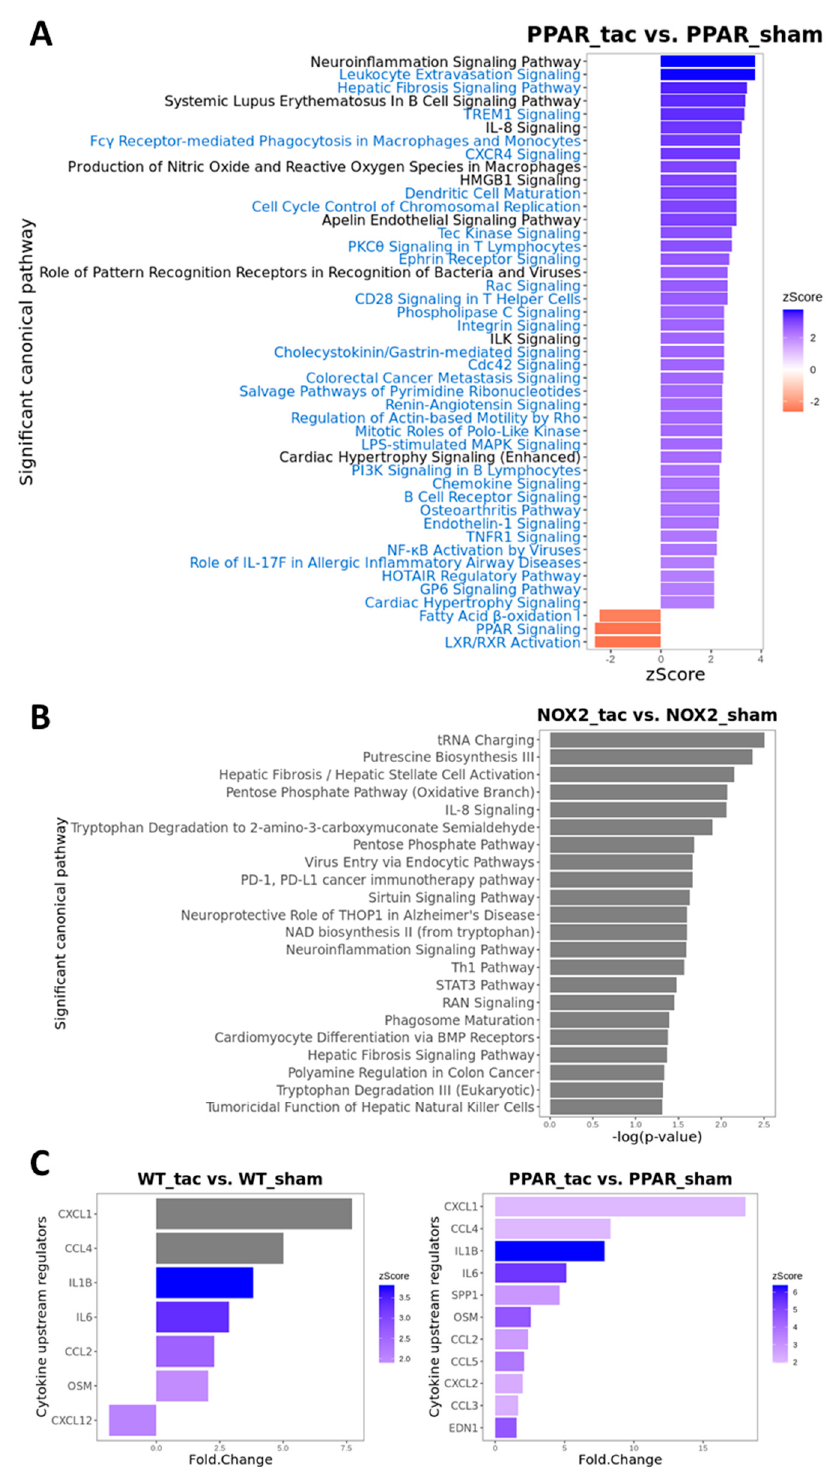
Figure 8. Canonical pathway analysis of differentially expressed genes using IPA. ( A ) Significantly enriched pathways in PPAR α − / − TAC vs. sham mice with activation z-scores > 2 (blue) or < − 2 (red). Pathway names highlighted in blue indicate unique enriched pathways in PPAR α − / − TAC vs. PPAR α − / − sham as compared to WT TAC vs. WT sham mice. ( B ) Significantly enriched pathways in Nox2 − / − TAC vs. sham mice (grey indicates that no activation z-score could be predicted by IPA). ( C ) Predicted cytokine upstream regulators associated with WT TAC vs. sham mice (left); and PPAR α − / − TAC vs. sham mice (right) with activation z-scores > 2 (grey indicates no activation z-score). N = 3–4.